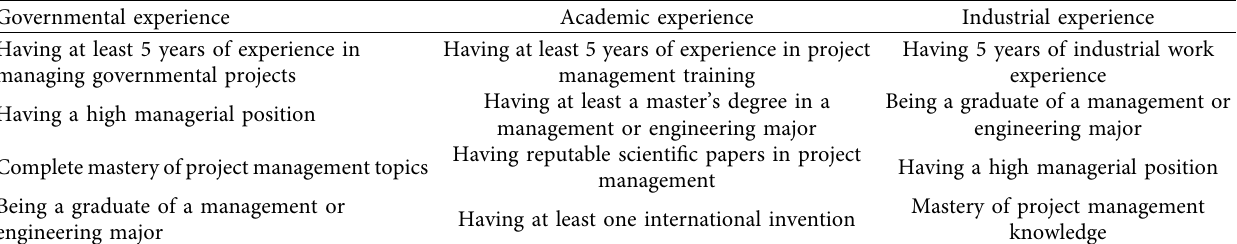
Table 4: Minimum qualifications required for selecting scientific industrial experts as decision-makers.